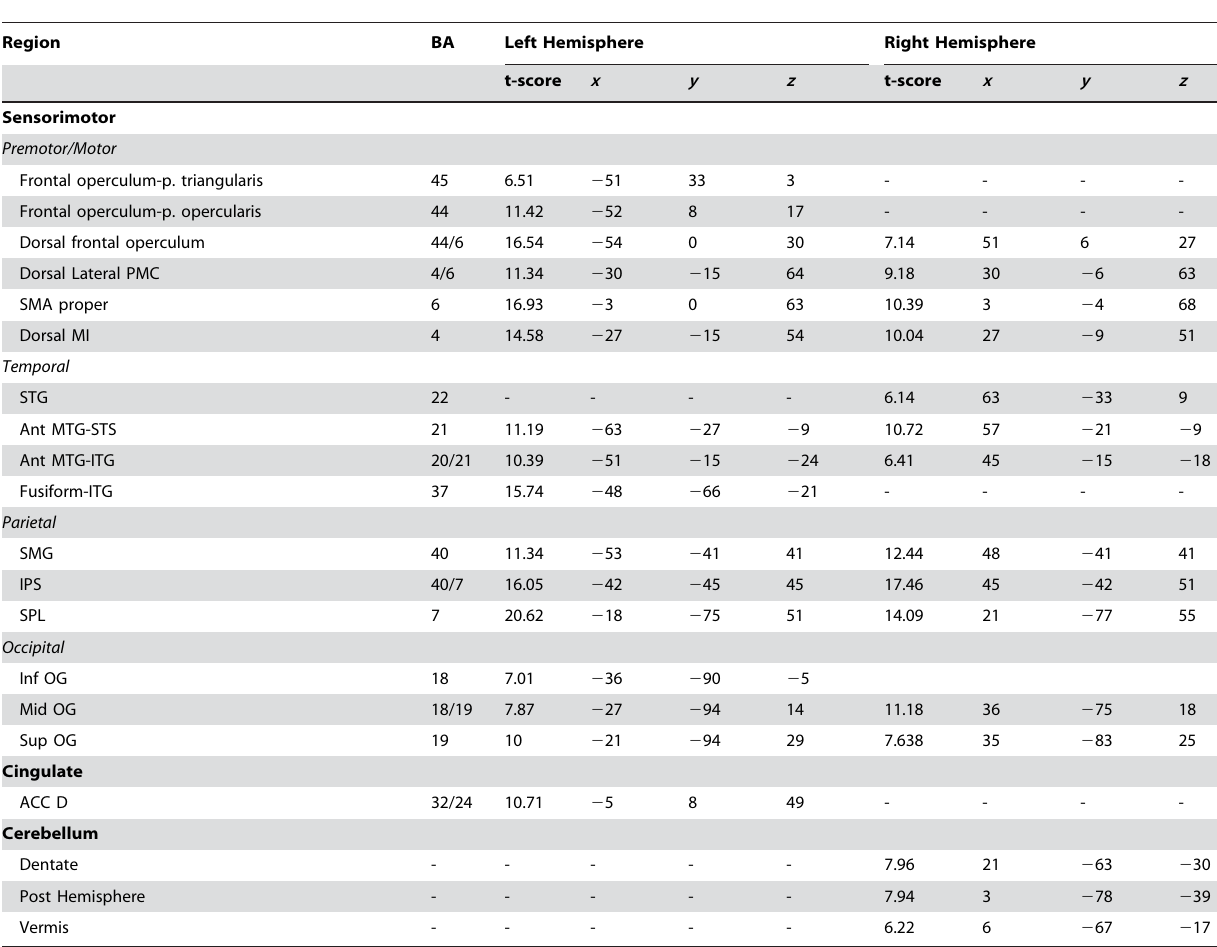
Table 3. Local maxima of brain activations within sensorimotor, cingulate, and cerebellar regions during improvisation.